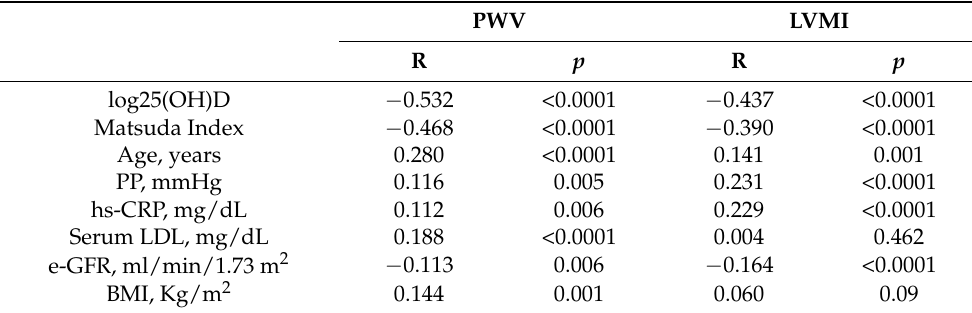
Table 2. Linear regression analysis on pulse wave velocity (PWV) and left ventricular mass index (LVMI) as dependent variables.